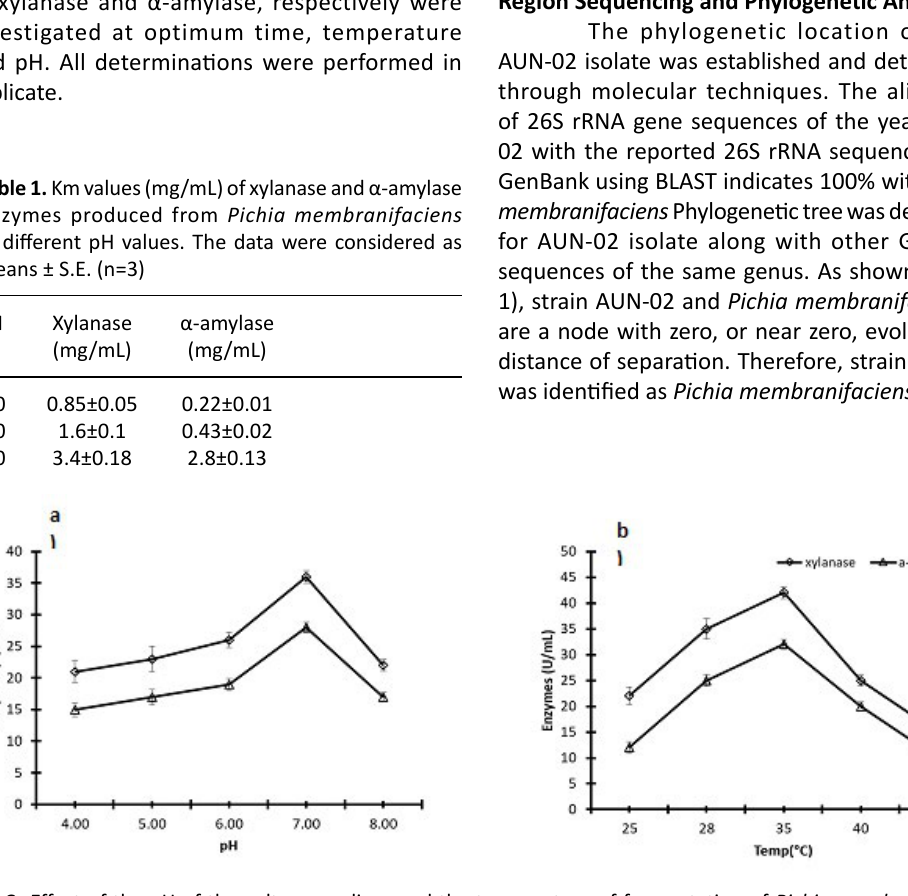
Fig. 3. Effect of the pH of the culture medium and the temperature of fermentation of Pichia membranifaciens AUN-02 on the production of xylanase and α- amylase. The data were considered as means ± S.E.